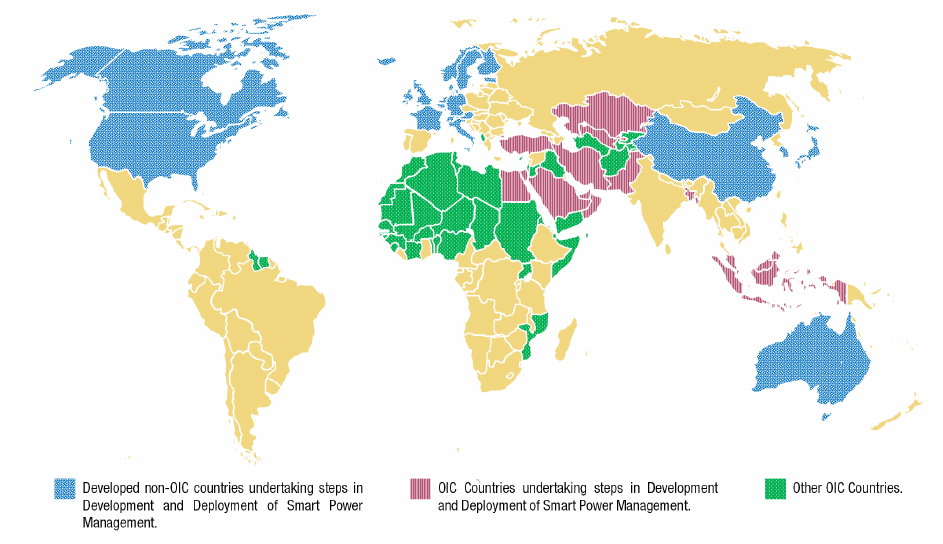
Figure 2. OIC countries and non-OIC developed countries on the world map that are undertaking steps in the development and deployment of smart power management. Table 2. Summary of advancements of the OIC member countries with smart power management initiatives.